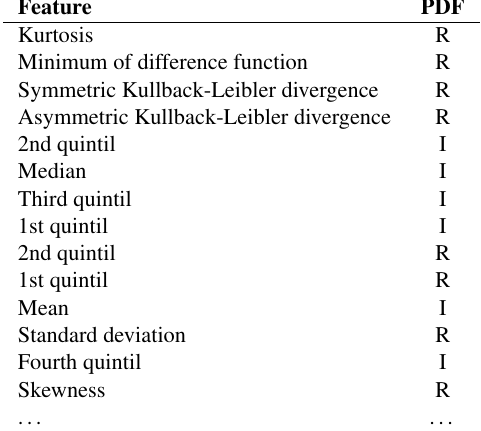
Table 1. Feature selection for simulated data for the classification of roofs with and without structures. I: inclination distribution, R: residual distribution.